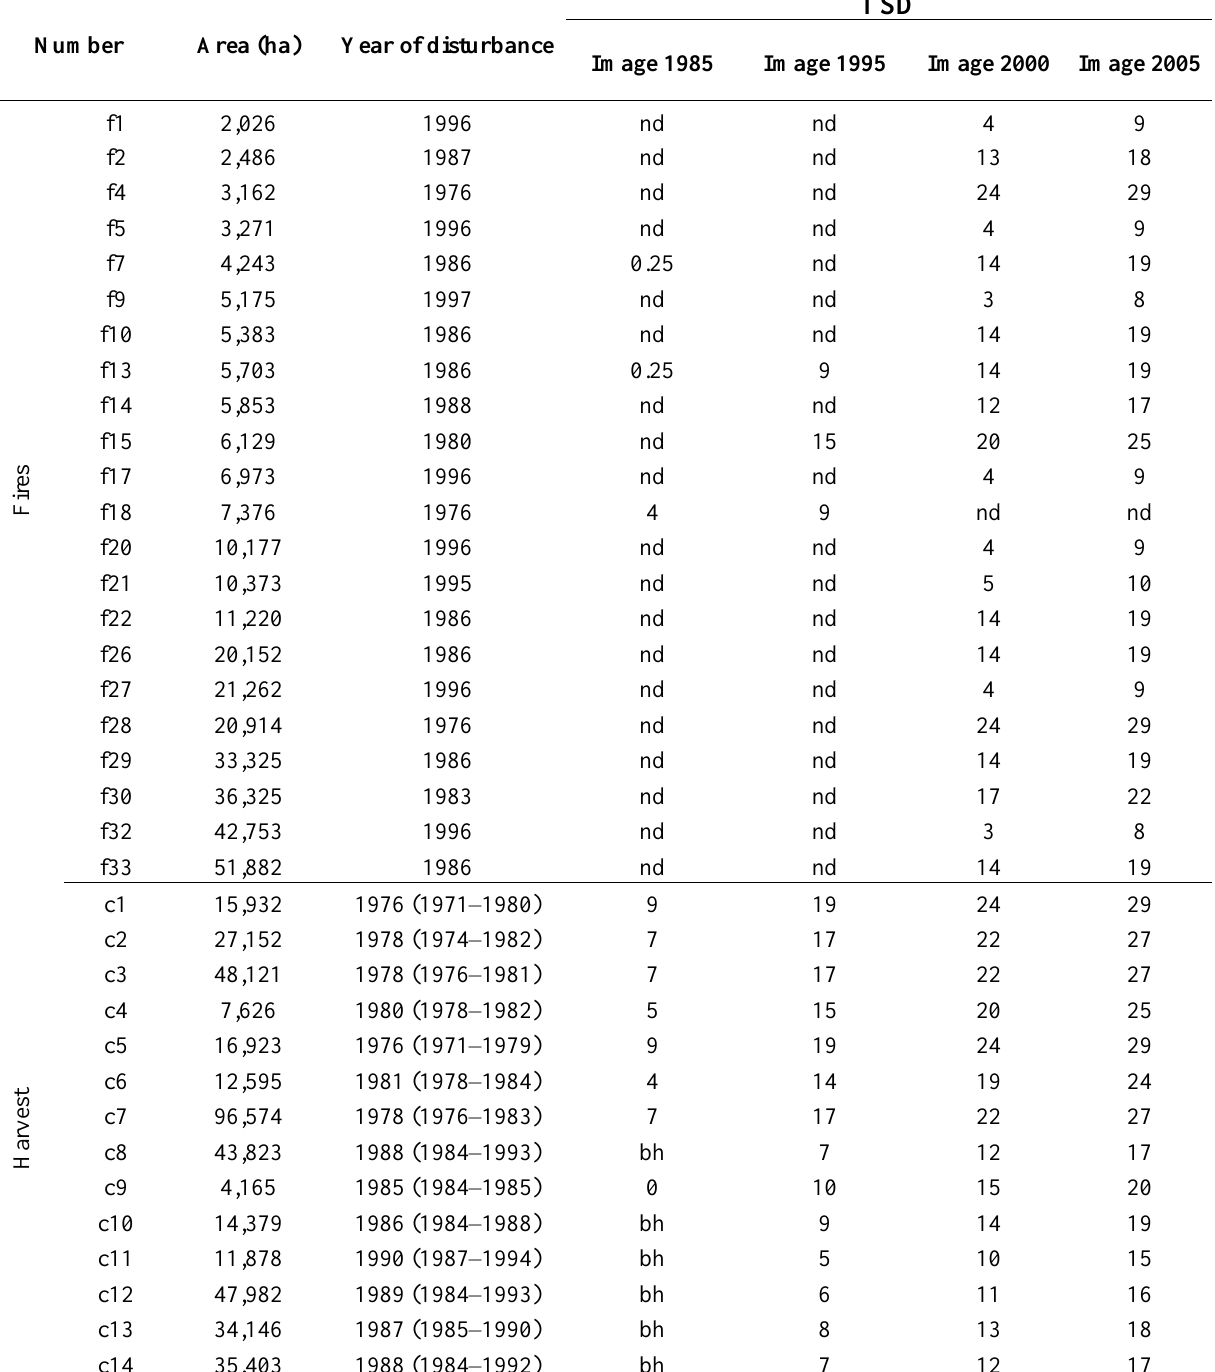
Table 1. Area, year of disturbance, and time since disturbance (TSD) for each image period for the 22 fire events and 14 harvested agglomerations. For the harvested agglomerations, the 10th and 90th percentiles (in area) are presented in parentheses after the year of disturbance. nd, no data; bh, before